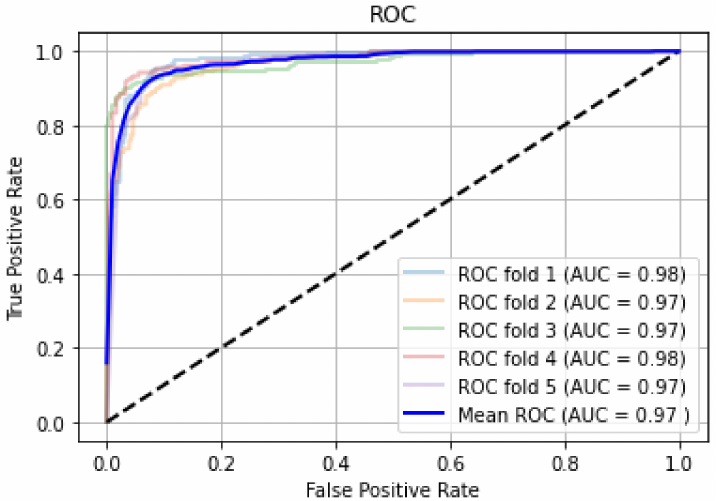
Figure 11. Cross-validated ROC on the augmented dataset using the CNN